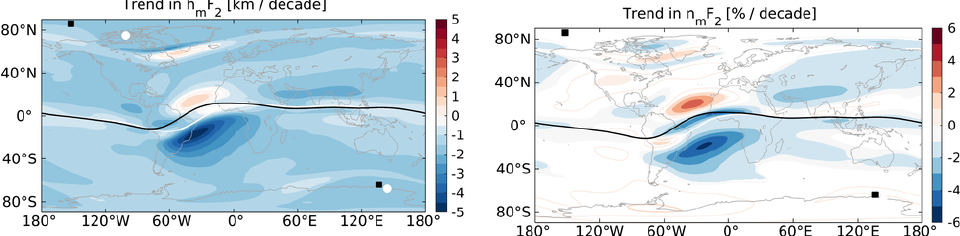
Figure 10. Trends in hmF2 (km/decade, left ) and NmF2 (%/decade, right ). Filled contours indicate that trends are statistically significant at the 95% confidence level, while line contours are used for non ‐ significant trends. The location of the magnetic equator and magnetic poles in 1950 (2015) are marked with a white (black) line and white circles (black squares), respectively. (Reproduction from Cnossen [10]: Figure 5).